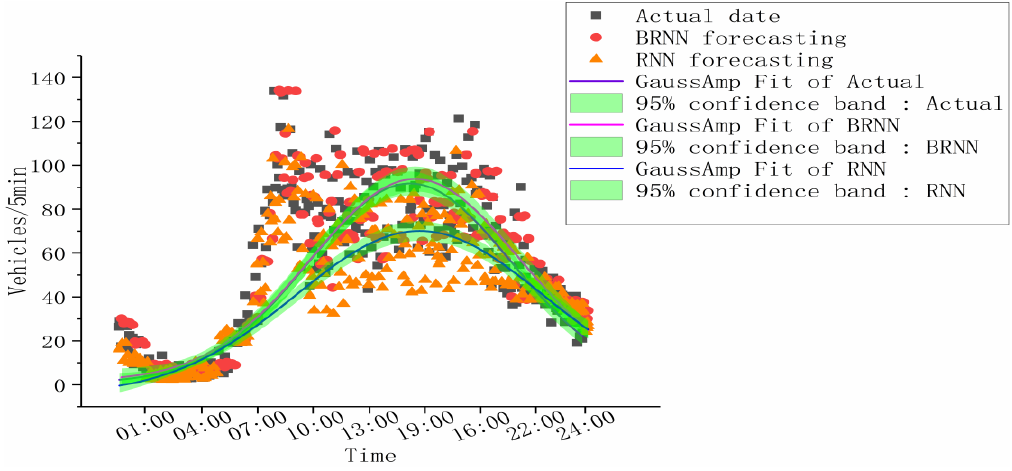
Figure 11 . Fitting curve of the scatter value.